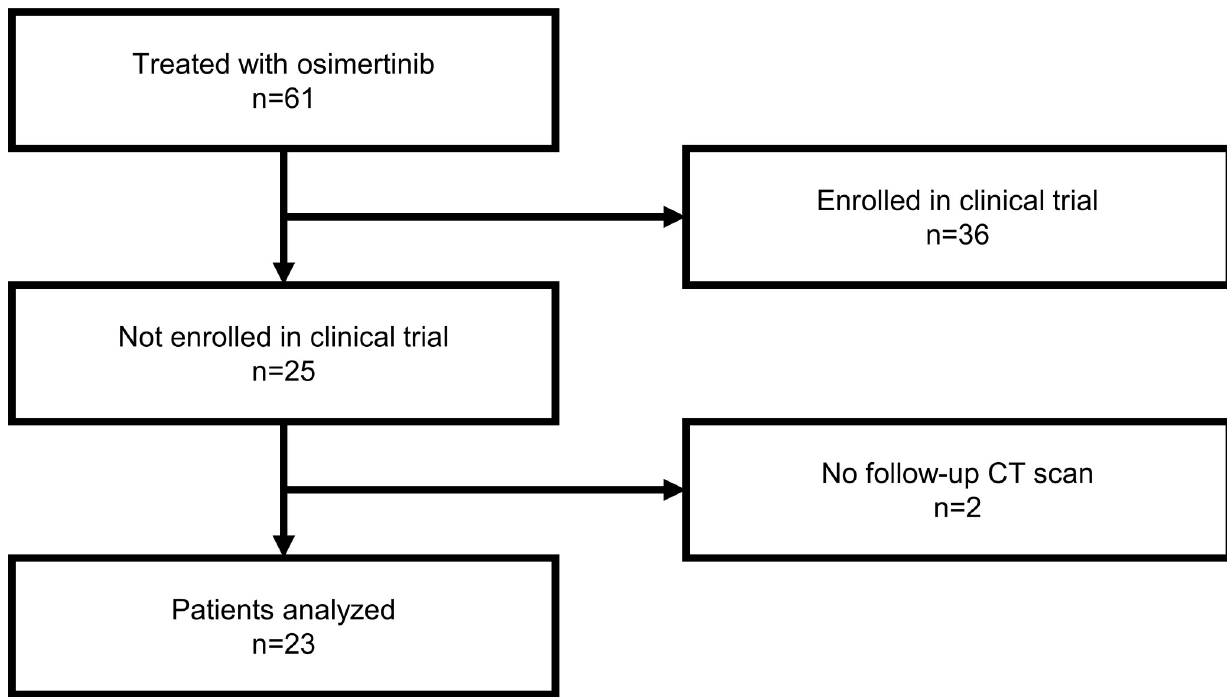
Fig 1. Flow chart of patient inclusion and